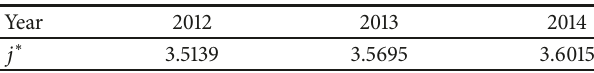
Table 5: Evaluated metarisk variables